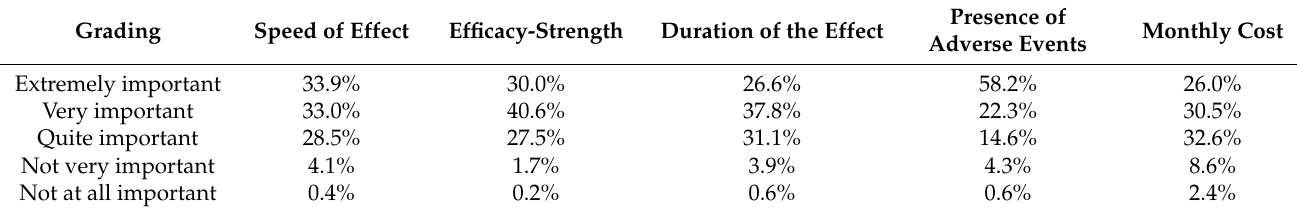
Table 4. Assessment of the importance of the considered attributes on the Likert